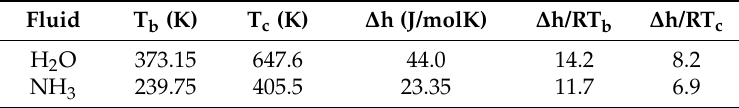
Table 1. Trouton’s rule for H 2 O and NH 3 at 1 atm.